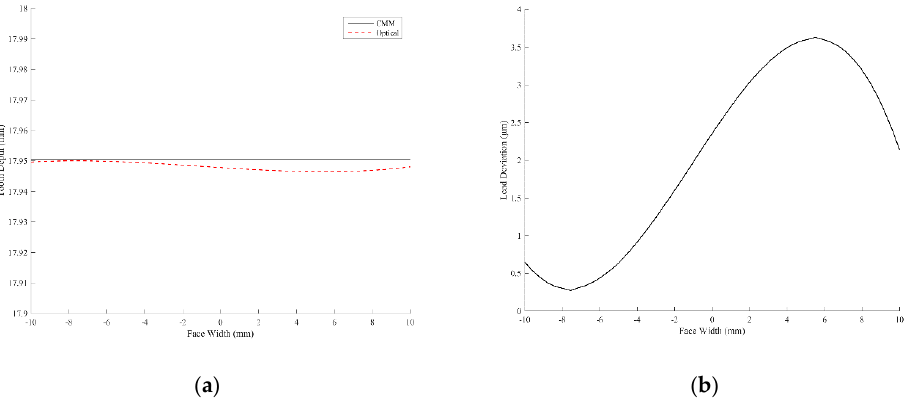
Figure 12. ( a ) Lead profiles measured by the CMM and optical system; ( b ) deviation of the lead profile measured by the projection moiré method from the CMM method.